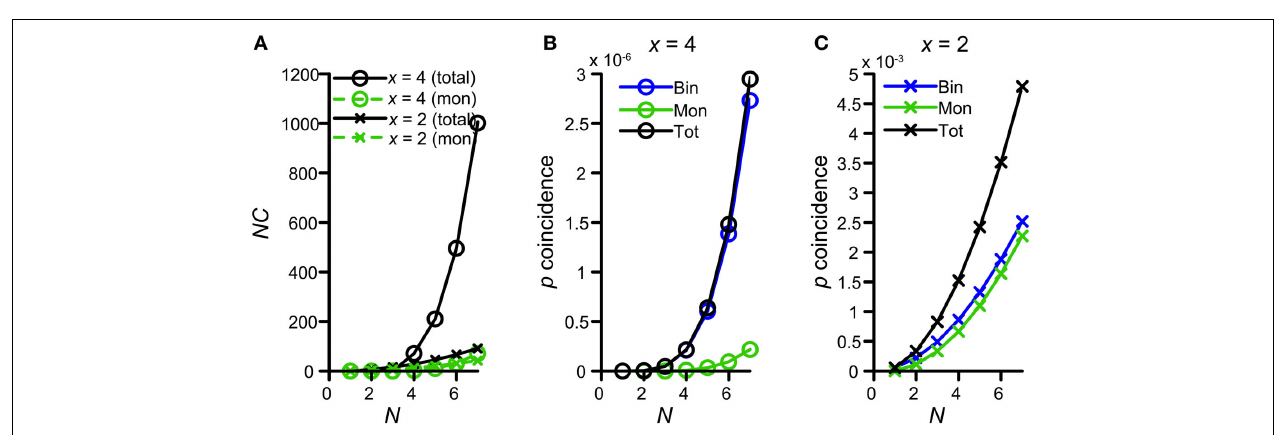
the minimal thr mon values for the accepted cases of one dataset. Black circles filled with red represent dataset in Figure 4 . Symbols are jittered to decrease overlap. cw = 50 μ s.